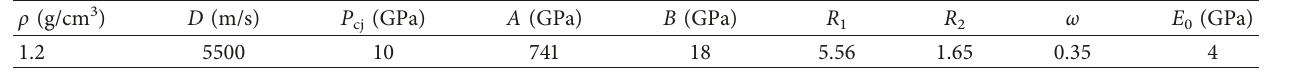
Table 3: Material parameters of the T220 explosive [25].